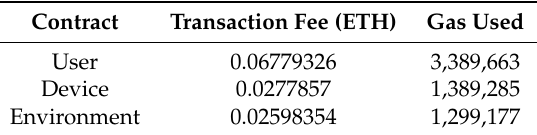
Table 2. Implementation cost of each contract.